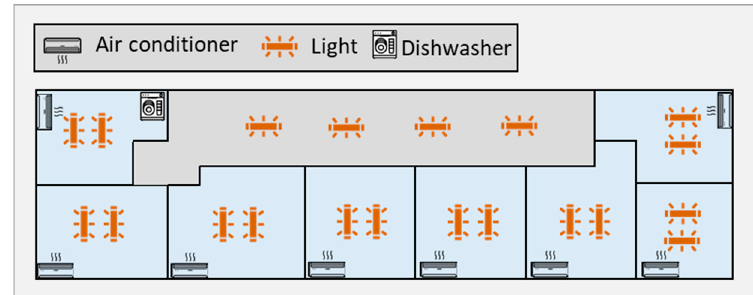
Figure 4. The plan of the building and controllable devices.